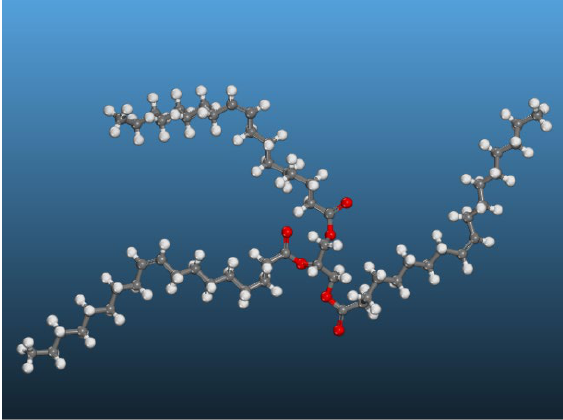
Figure 1. Atomic structure of triglyceride molecule. Table 1. Main components and their mass fractions of Karamay 25 # insulating oil.